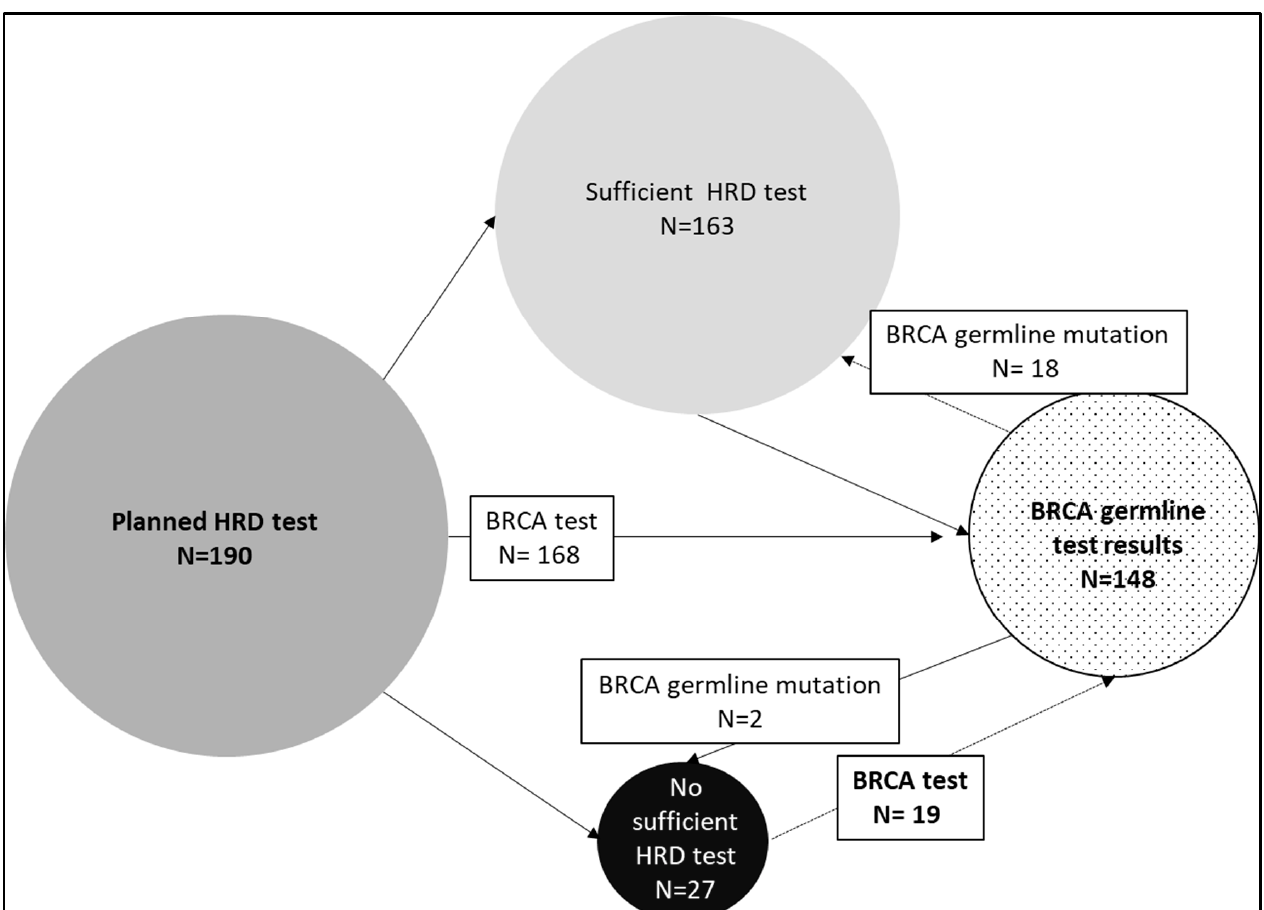
Figure 4. Description of HRD test results in combination with BRCA1/2 germline test results. HRD represents homologous recombination deficiency; BRCA represents breast cancer.